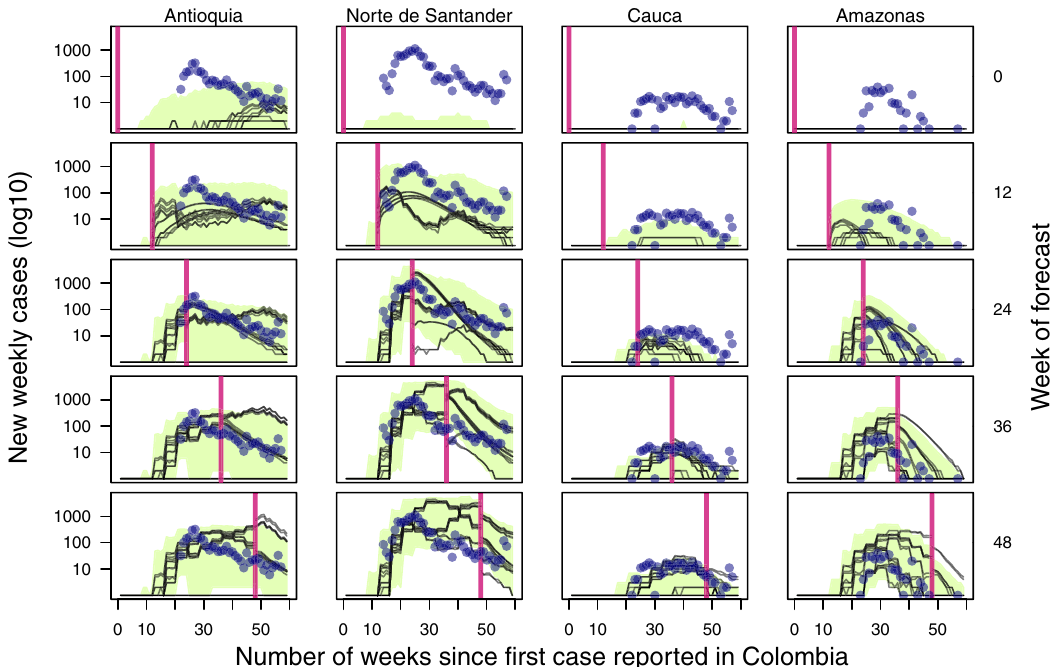
Fig. 2 Observed incidence (navy points) with the median forecast for 16 models (black lines) with the equally weighted ensemble model (green band) for Antioquia, Norte de Santander, Cauca, and Amazonas at fi ve points throughout the epidemic. Plotted departments re fl ect differences in population, epidemic size, and geographic regions of Colombia and are represented by each column. The vertical pink line indicates the point at which the forecast was made (also labeled on the right axis), with data to the left of the line assimilated into the model fi t. Forecasts to the right of the vertical line change as more data are assimilated into the model, while the model that fi ts the left of the vertical line do not change. The green band re fl ects the 50% credible interval of the equally weighted ensemble